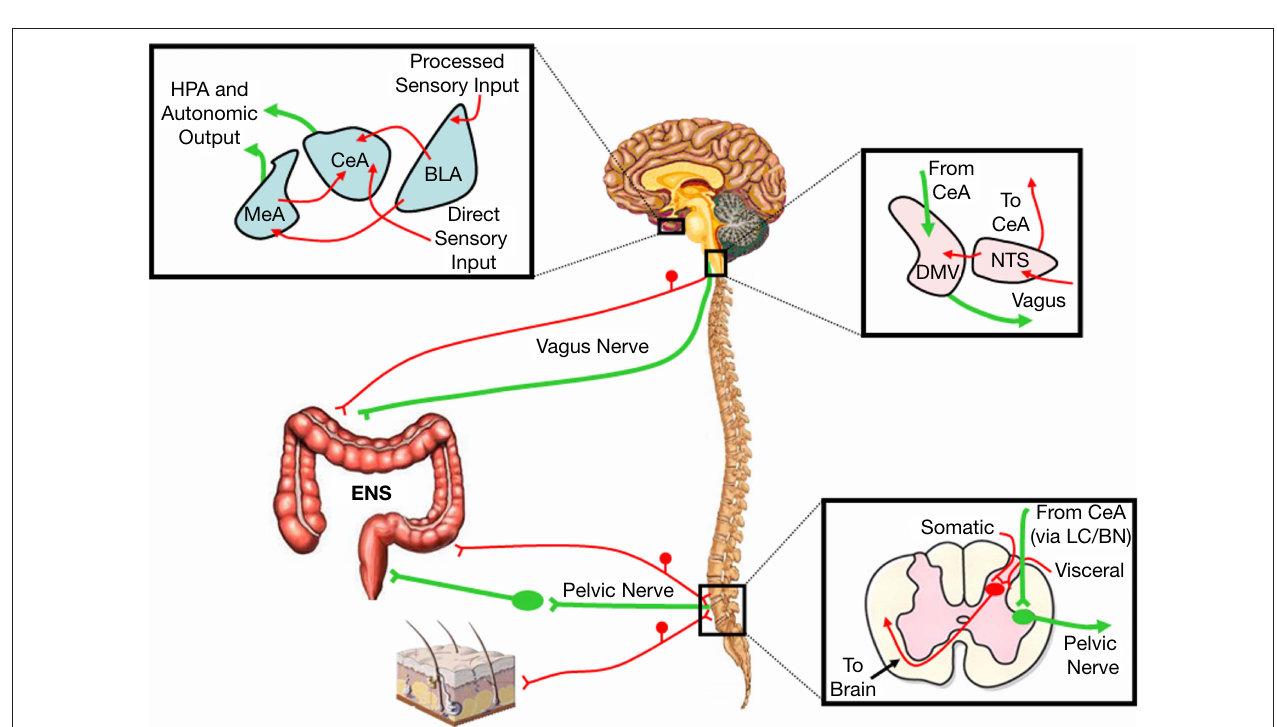
Figure 1 | Mechanisms for amygdala-mediated integration of abdominal and cutaneous pain, gi motility, and anxiety. All projections are reciprocal and connectivity is simplified for clarity. Ach, acetylcholine; AVP, arginine vasopressin; BN, Barrington’s nucleus; BNST, bed nucleus of the stria terminalis; CCK, cholecystokinin; CGRP, calcitonin gene-related peptide; CRF, corticotropin releasing factor; DMV, dorsal motor nucleus of the vagus; Glu, glutamate; Hypo,